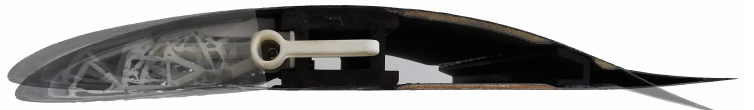
Figure 12. Morphing wing demonstrator based on topology optimization results showing undeformed and deformed states